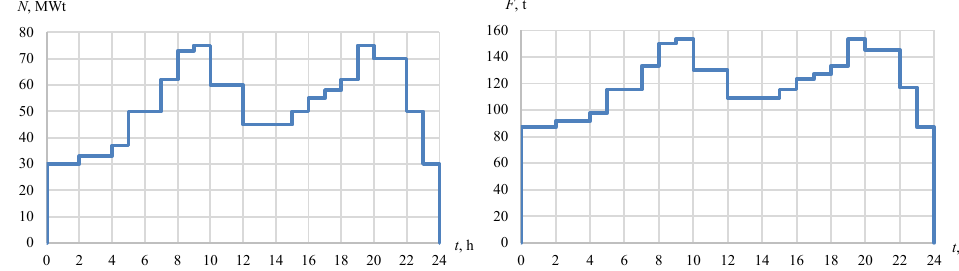
Fig. 3. The plots of the daily consumption of: а ) electricity, b)